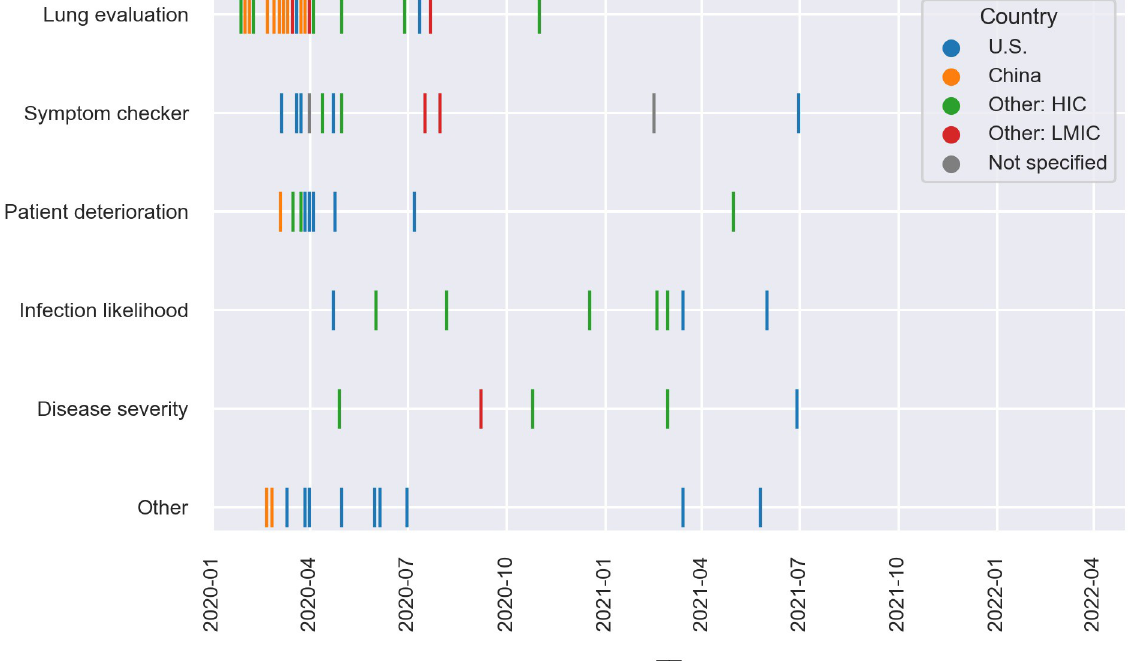
Fig 2. Date and country of first confirmed deployment in the COVID-19 response, by application category. Note: Dates have been jittered up to 12 days within the same month.